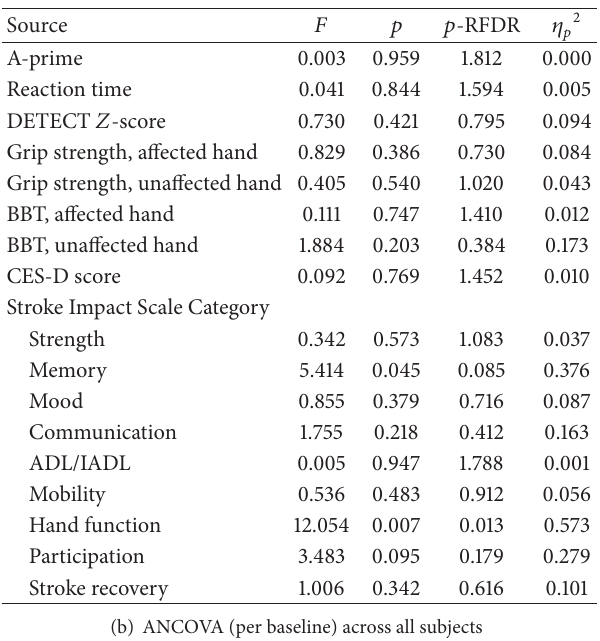
Table 3: ANCOVA table for (a) treatment group, (b) baseline performance effect, and (c) treatment group × baseline performance interaction for A-prime, reaction time, DETECT 𝑍 -score, grip strength, BBT, CES-D, and SIS categories. There was a significant main effect of treatment group on the SIS affected hand function domain. There was a significant main effect of baseline performance onCES-DscoreandSISmemory,mood,affectedhandfunction,and socialparticipationdomainscores.Therewasasignificanttreatment group × baseline performance interaction for SIS affected hand function domain